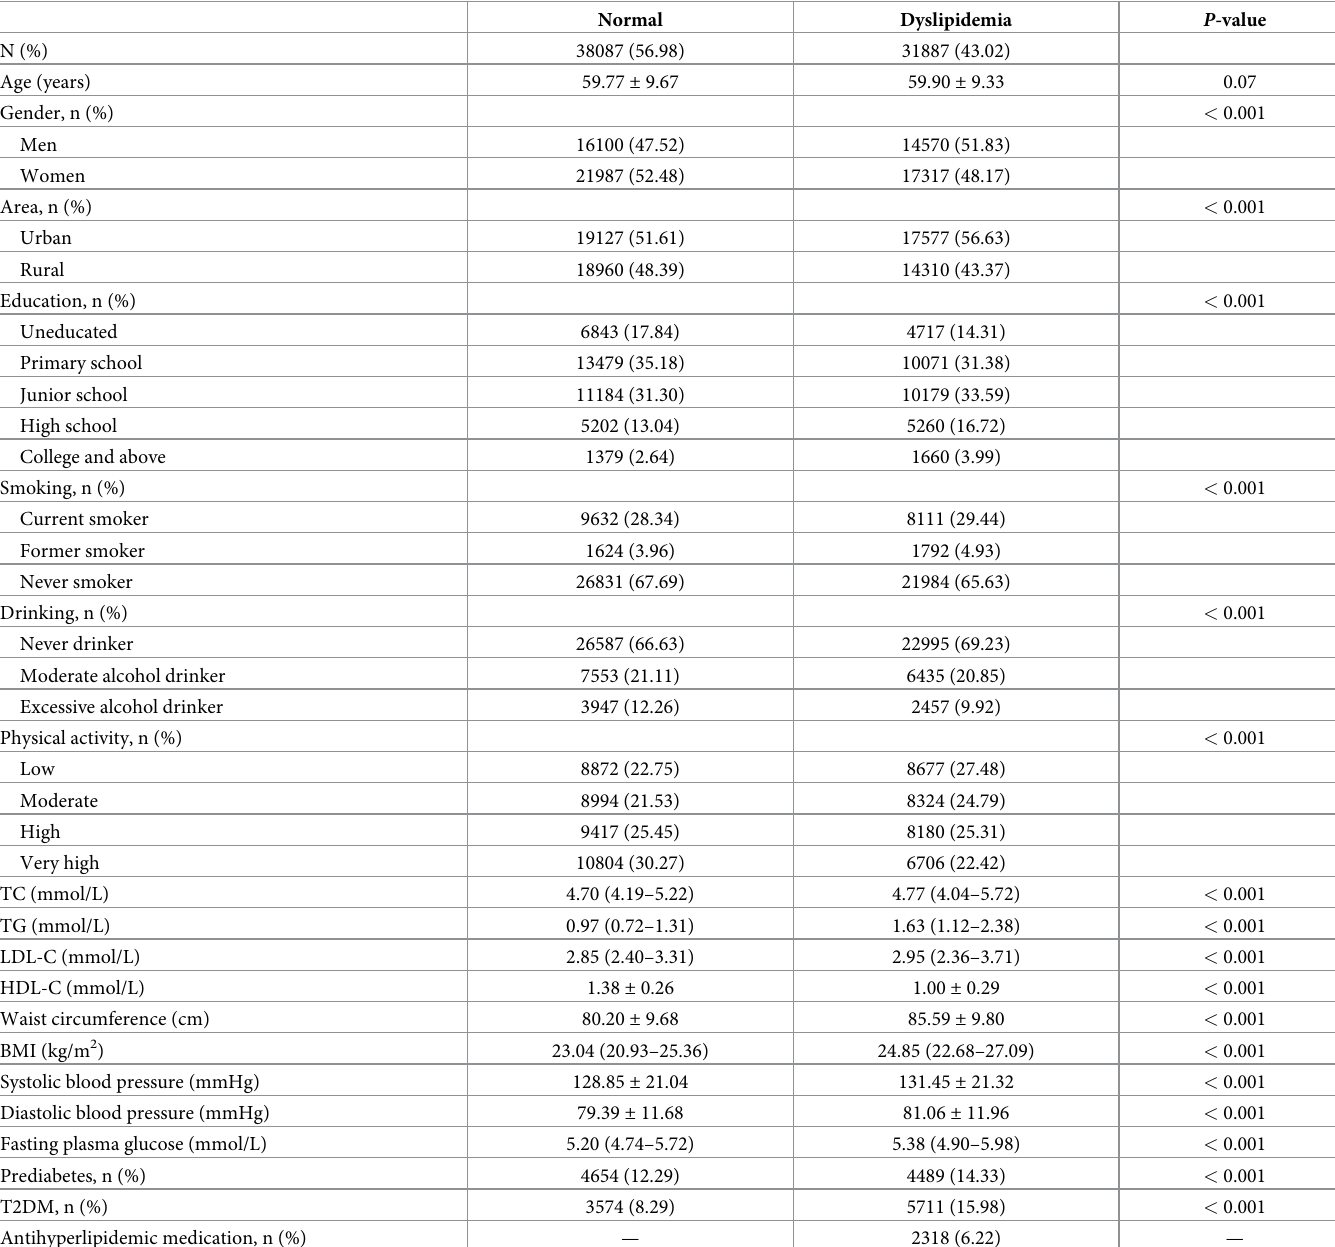
Table 2. Characteristics of the participants according to dyslipidemia status (69974).